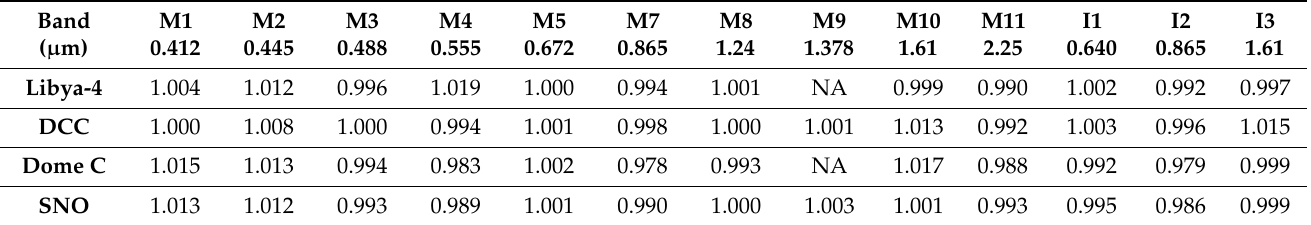
Table 2. The RSR correction between SNPP and NOAA20 VIIRS RSB derived using Equation (1) for the four vicarious approaches. Note results for M11 are based on Hyperion data for DCC and MODTRAN simulations for other